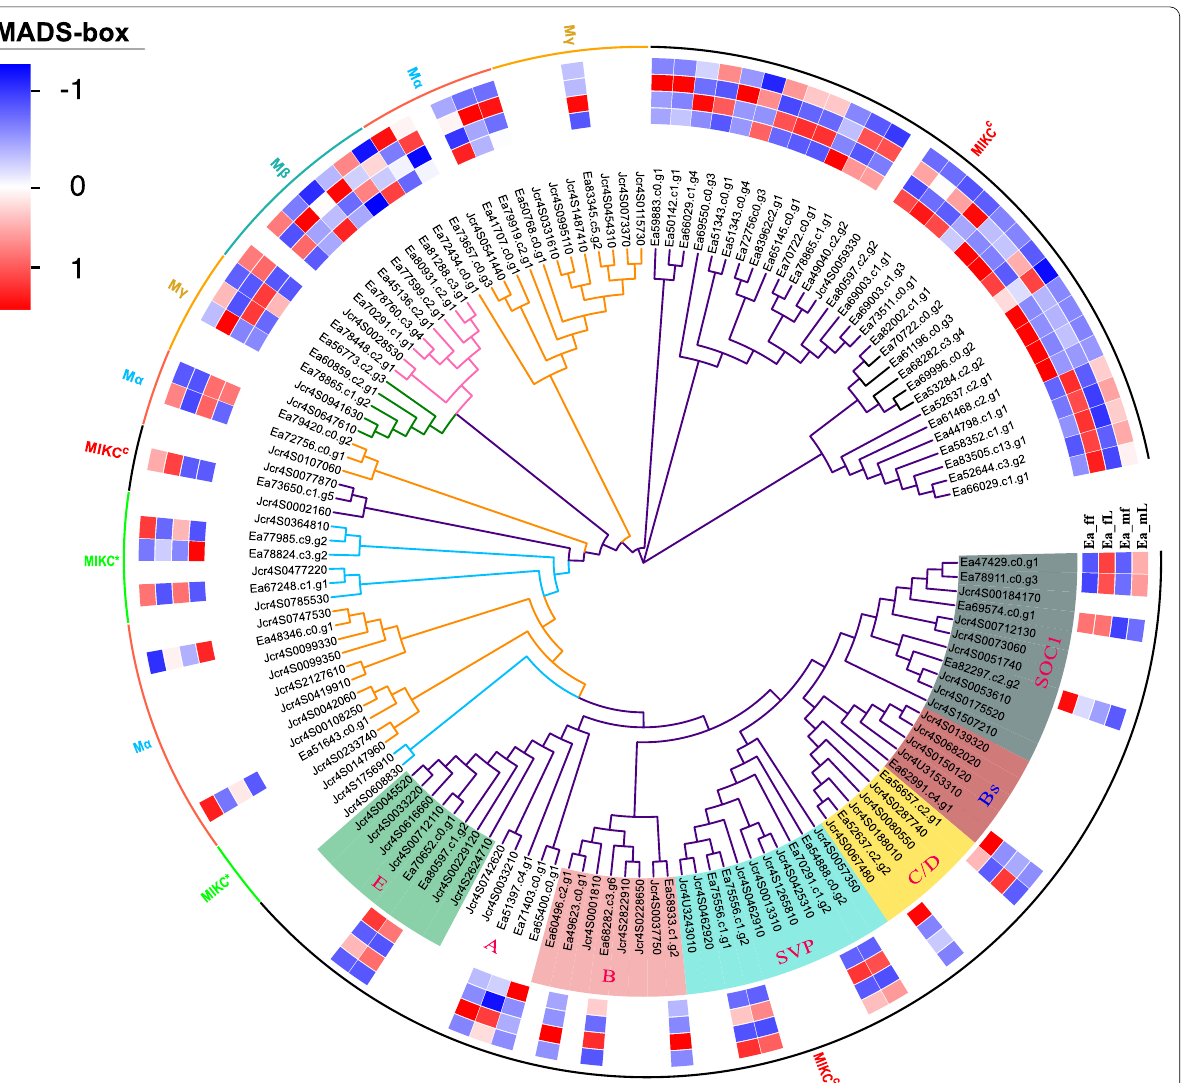
Fig. 5 Phylogenetic analysis (inner circle) for J. curcas and E.agallocha MADS-box proteins, and heatmap analysis (outer circle) of MADS gene family in the E.agallocha of Ea_ff, Ea_fL, Ea_mf, and